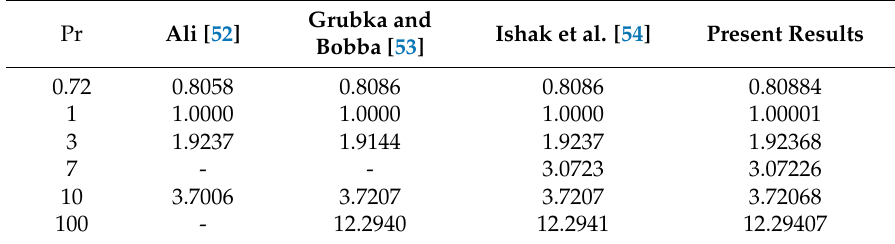
Table 5. Comparison of − Θ (cid:48) ( 0 ) between present results and previously existing results for different values of Pr by setting Rd = λ = Φ = 0 and κ → ∞